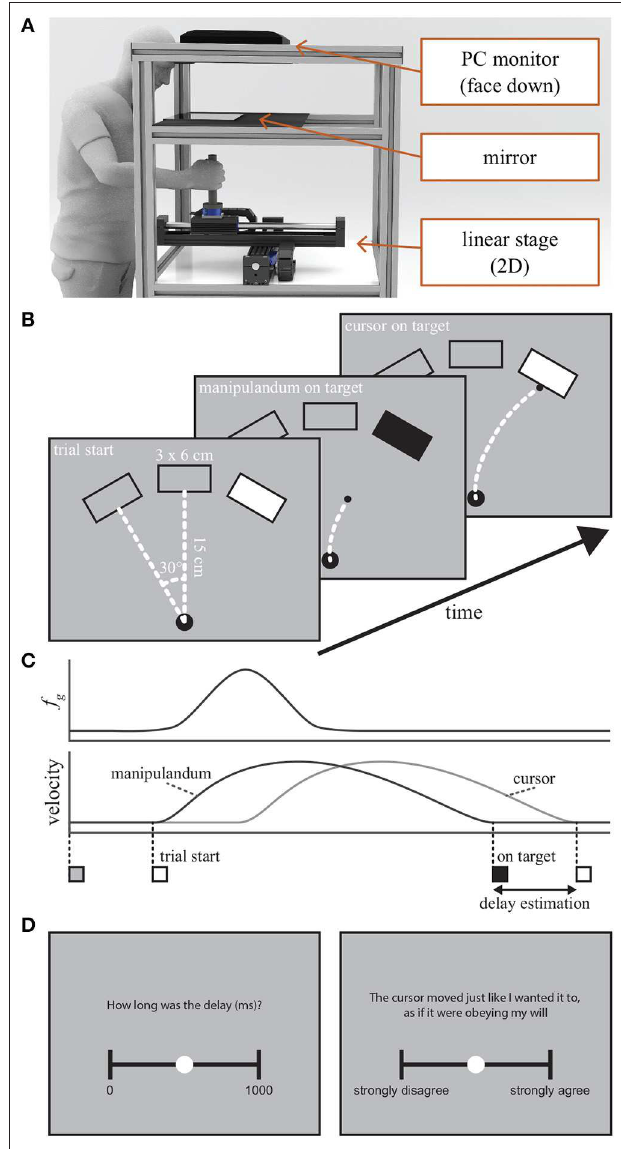
FIGURE 1 | (A) An illustration of the workspace. The visual displayed was superimposed to the real workspace with a 2D linear stage manipulandum by mirroring the PC display. (B) The visual task space shown to the participants during the Reaching phase. The start of a trial was indicated by turning the color of the target platform to white. When the manipulandum and the delayed cursor reached the target, the platform changed the color to black and white, respectively. (C) An illustration of the manipulandum/cursor velocity profiles and guiding force ( f g ) in a single trial. (D) Scales for delay estimation and